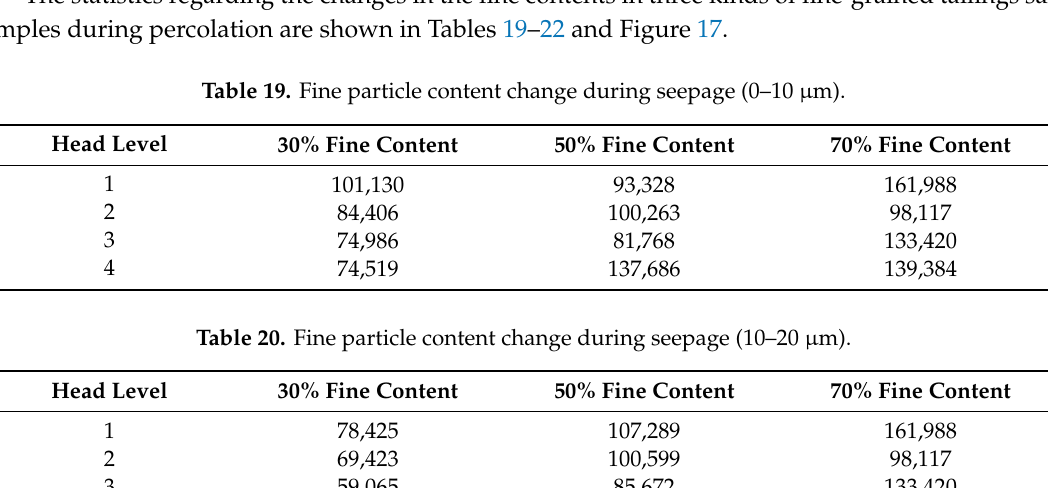
Table 19. Fine particle content change during seepage (0 – 10 µm).